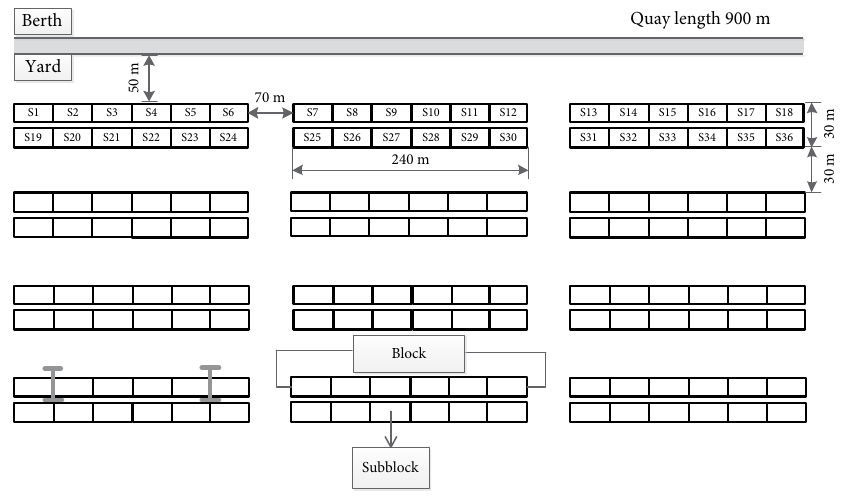
Figure 5. The layout of one yard in Dalian container